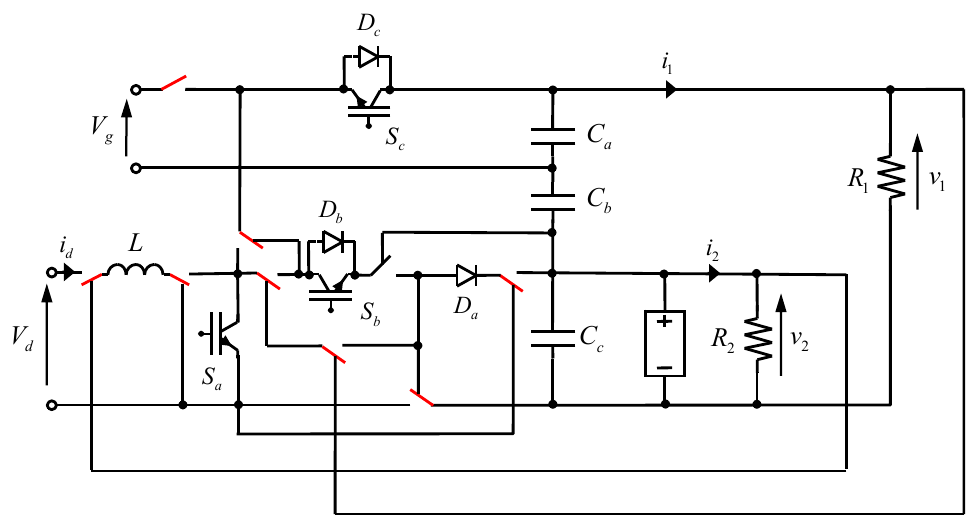
Figure 2. Reconfigurable integrated